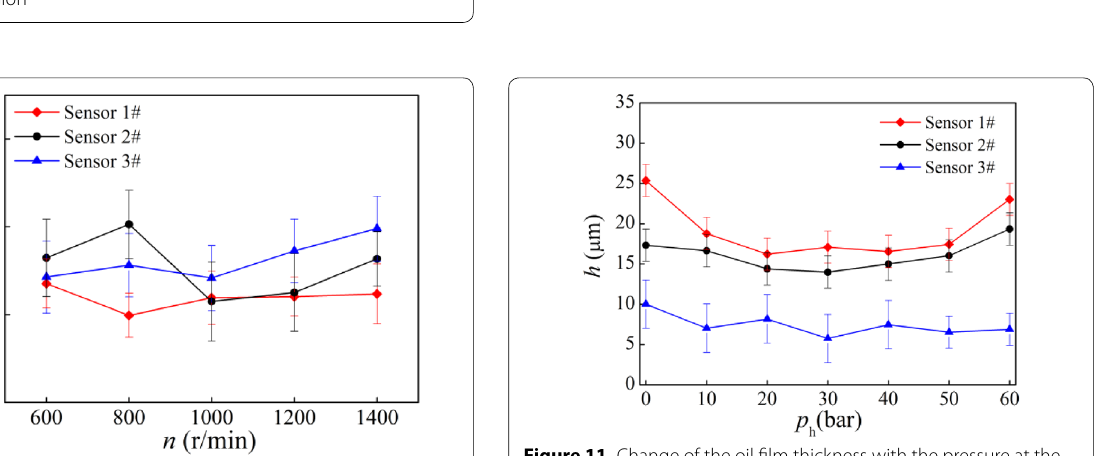
Figure 9 Change of the oil film thickness with the rotation speed at high pressure region